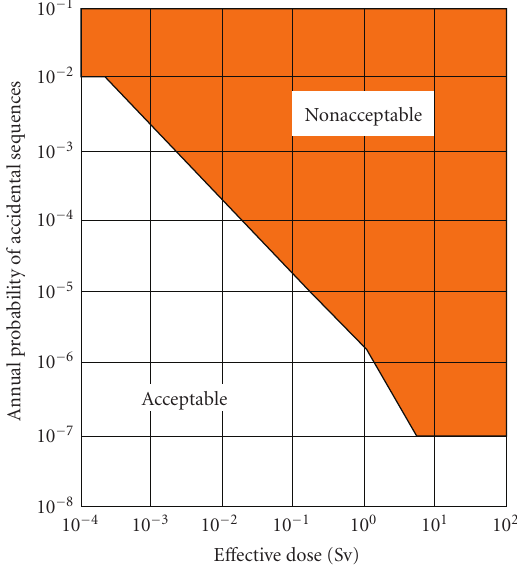
Figure 1: The criterion curve for the